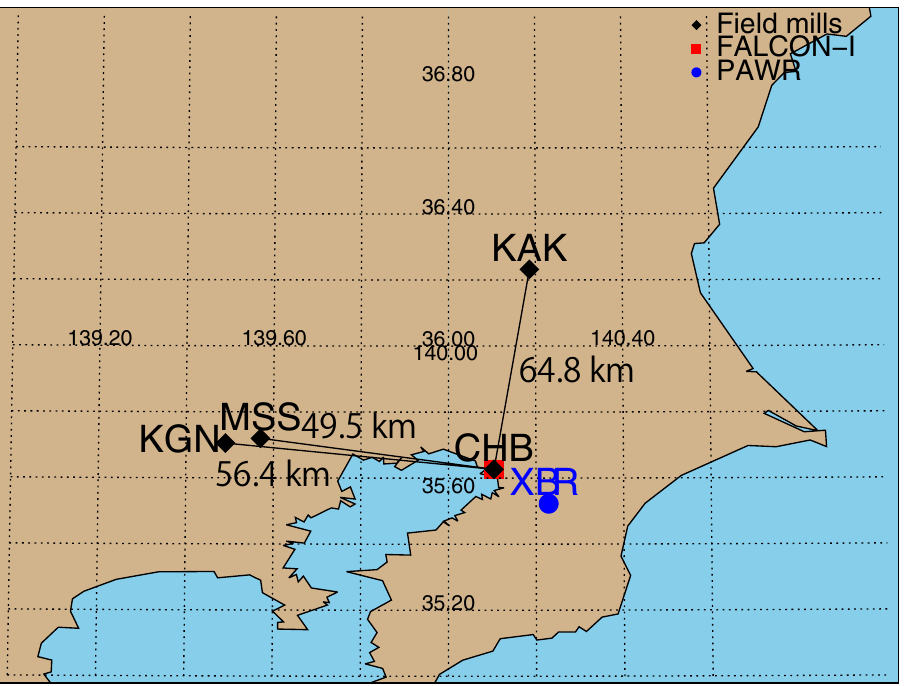
Figure 1. Location of field mills at Chiba University (CHB, 35.63° N, 140.10° E), Kakioka (KAK, 36.23° N, 140.19° E), Koganei (KGN, 35.71° N, 139.49° E), and Musashino (MSS, 35.72° N, 139.57° E); the FALCON-I at CHB; and a PAWR operated by Japan Radio at Chiba (XBR, 35.52° N, 140.23° E), Japan. This map was drawn using the Interactive Data Language (IDL) ver. 8.3 (https ://www.harri sgeos patia